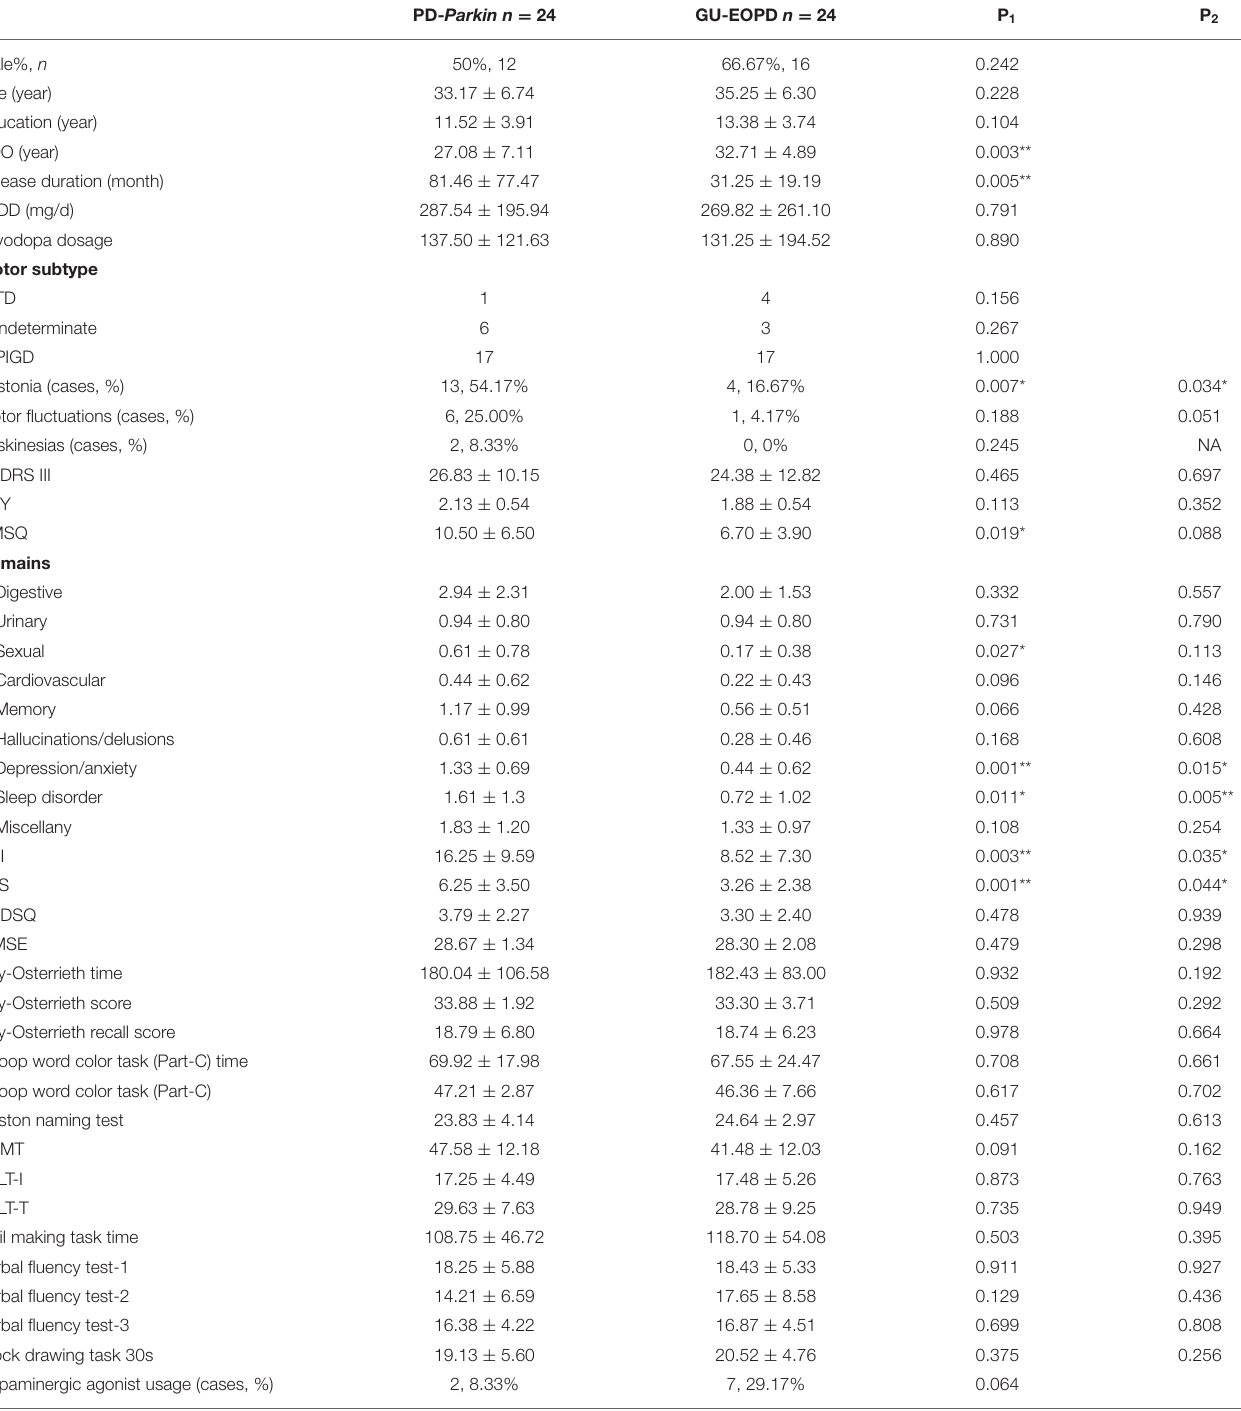
TABLE 1 | Demographic and clinical characteristics of overall study